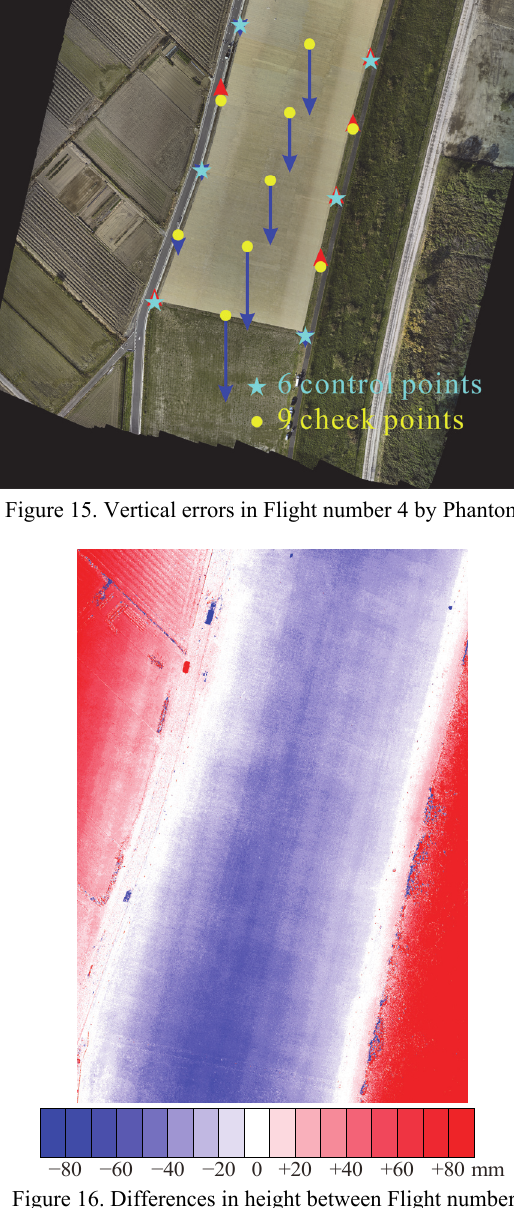
Figure 18. Differences in height between UAV photogrammetry and